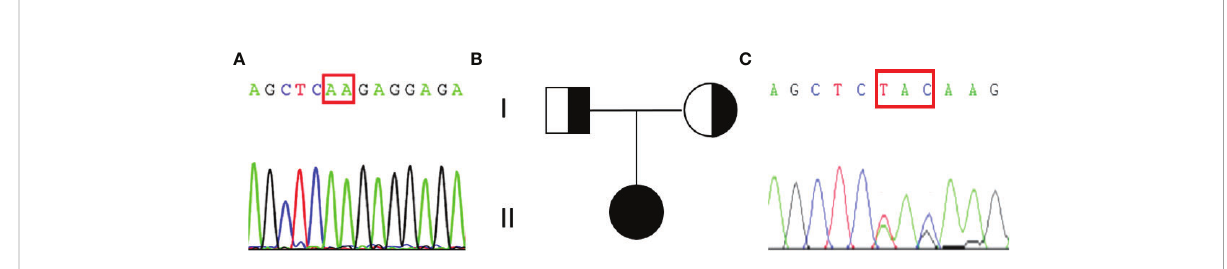
FIGURE 3 Results of the sequencing of CYP17A1 gene and the pedigree of the patient ’ s family. (A) The patient was homozygous for the pathogenic variant c.985_987delTACinsAA (p.Y329Kfs*90). The red rectangular represents the altered nuclear acid. (B) Pedigree of the patient ’ s family. (C) Her parents were all heterozygous for c.985_987delTACinsAA (p.Y329Kfs*90) pathogenic